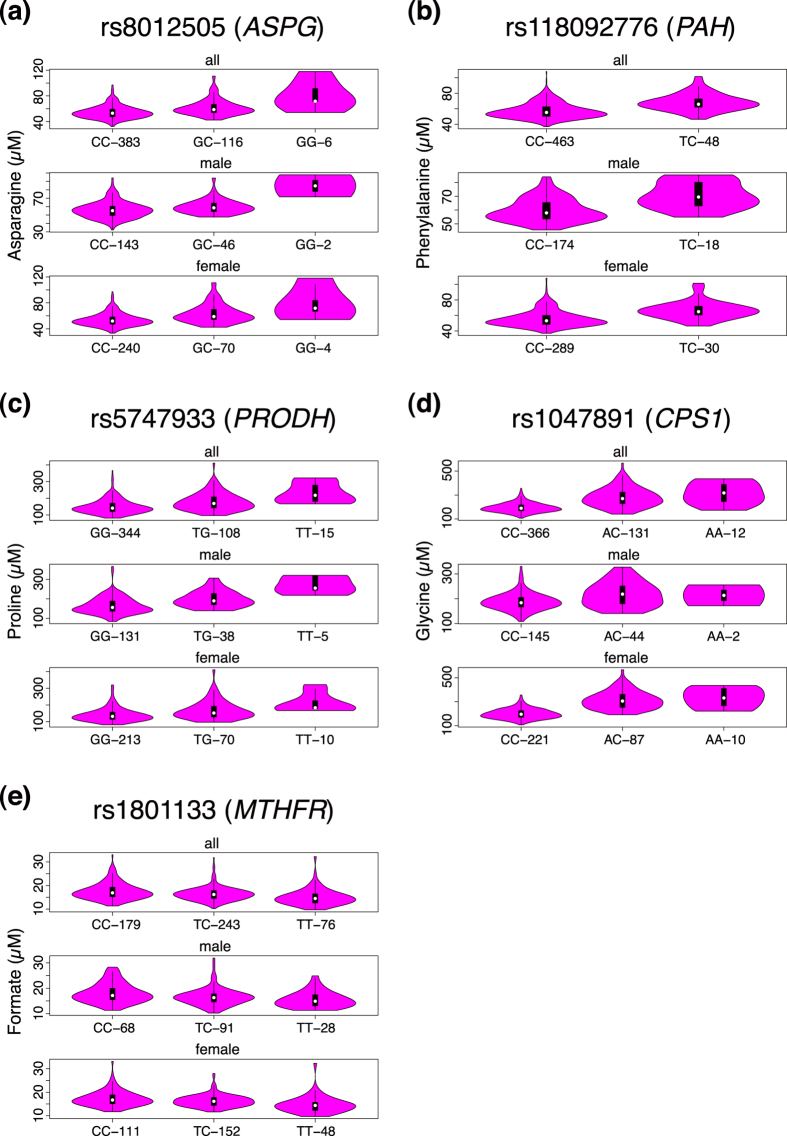
Distribution of the Plasma Metabolite Concentration.Distribution of the plasma metabolite concentration across the genotypes of each locus summarized in Table 1 was shown using a violin plot. These figures were made using R package.